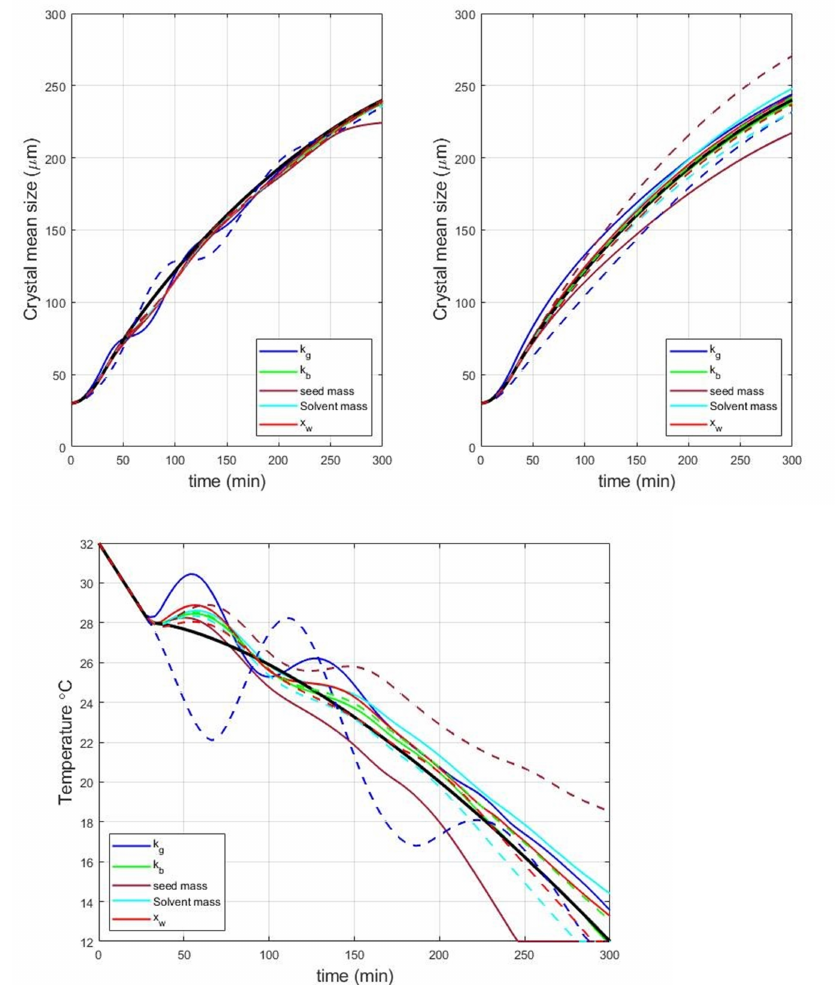
Figure 4. Controlled mean crystal size ( top-left ), open-loop mean crystal size ( top-right ) and con- trolled temperature profile ( middle ) in the presence of and obtained for the application of the Moving Window methodology to the RBF soft sensor with single step disturbances (positive disturbance: full line; negative disturbance: dashed